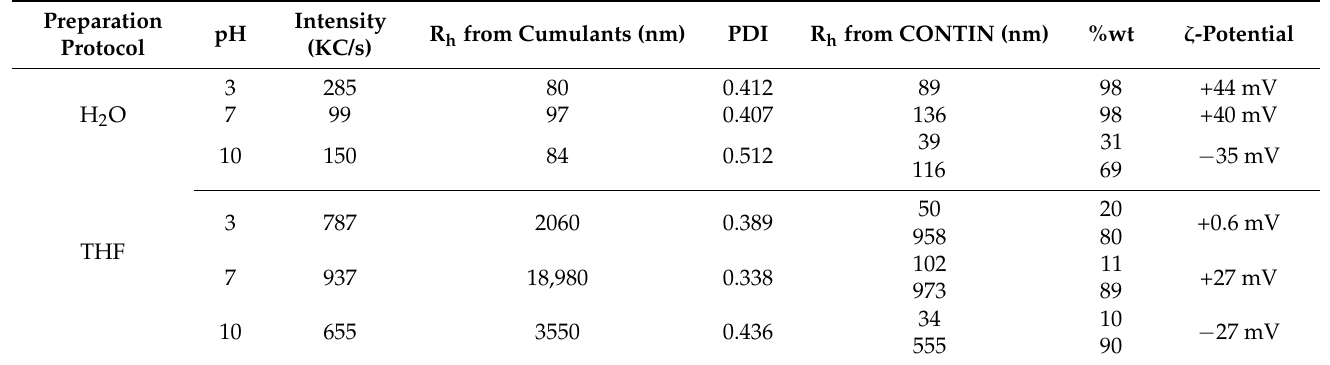
Table 5. Effect of pH on the properties of copolymer PQFD 20% aqueous